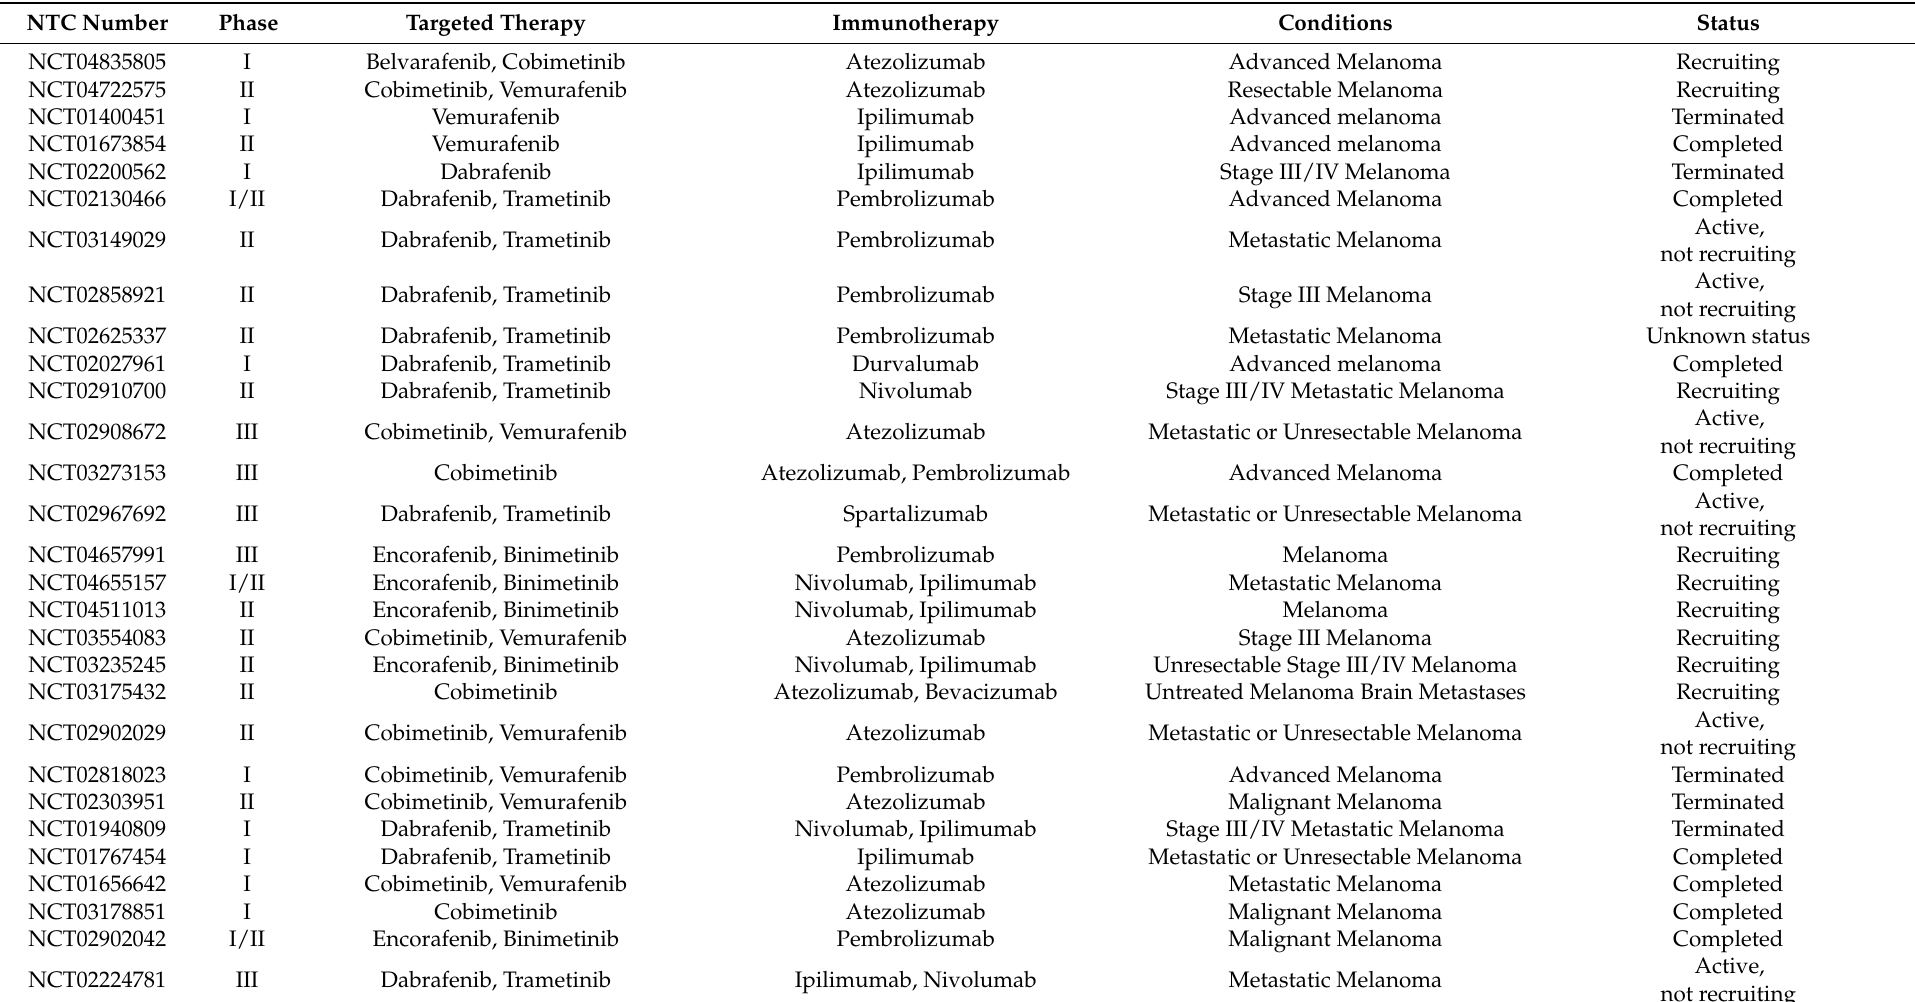
Table 1. Clinical trials combining BRAF and MEK inhibitors with ICIs in